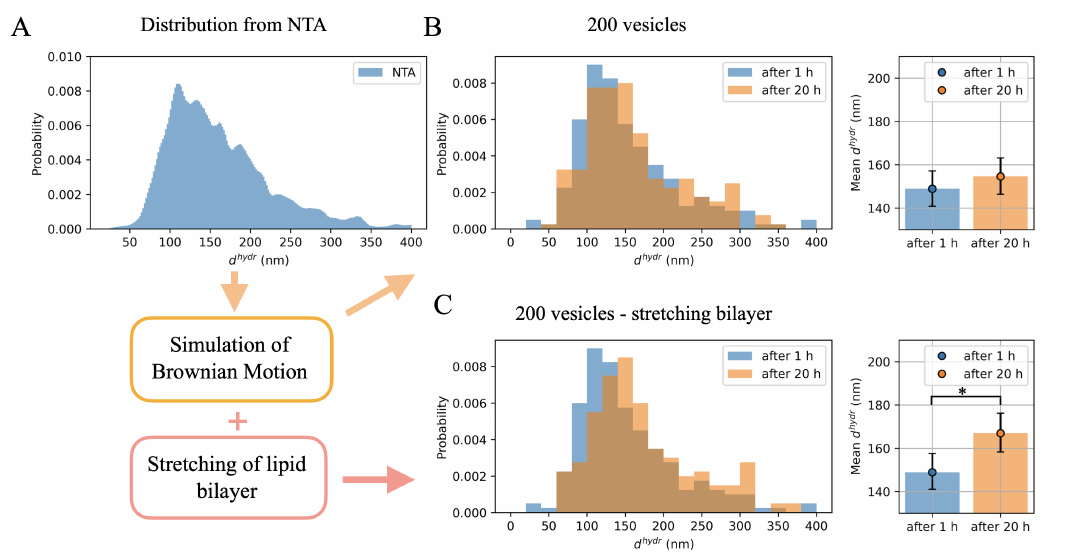
Figure 3. Results of the Monte Carlo simulation of adhesion of vesicles with hydrodynamic diameters drawn from the distribution obtained from NTA ( A ). In ( B ) the hydrodynamic diameter distributions of 200 vesicles are randomly selected out of those attached to the surface. The blue histogram corresponds to the situation after 1 h and the orange one after 20 h from placing a sample drop of 1 mm thick on the mica substrate. ( C ): taking into account the additional 8% linear membrane stretching for 200 vesicles selected after 20 h made the shift in time of mean vesicle hydrodynamic diameter statistically significant; * means that 95% CI of the two outcomes do not